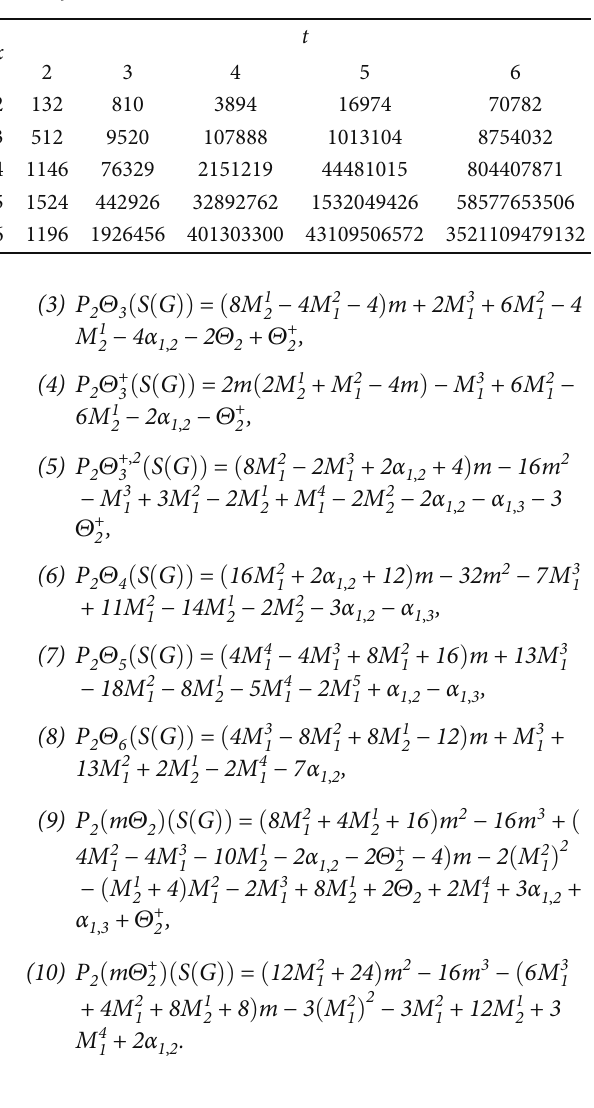
Figure 1: The rooted tree T ð 3, 3 Þ . Table 1: The Laplacian coe ffi cients c ð T ð 3, t ÞÞ , where x , t ∈ f 2, n − x 3, 4, 5, 6 g